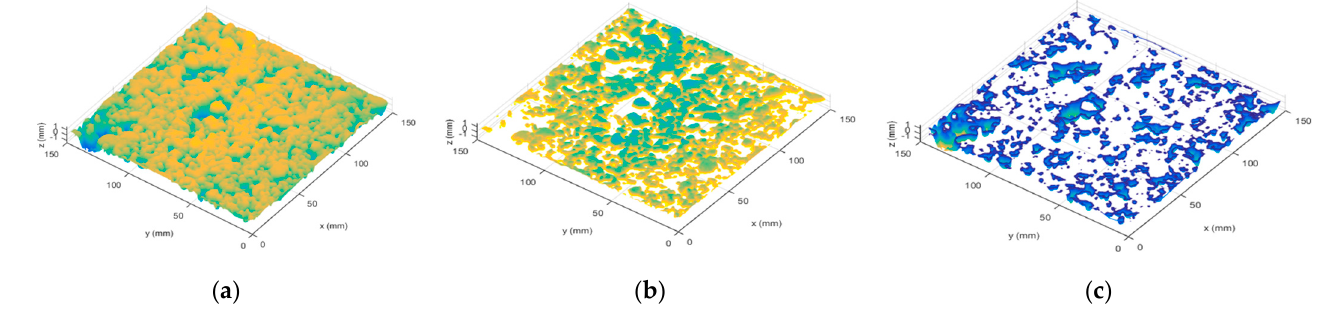
Figure 4. Pavement texture morphology visualization under different conditions: ( a ) dry pavement; ( b ) wet pavement; ( c ) anti-skid non-contribution area.